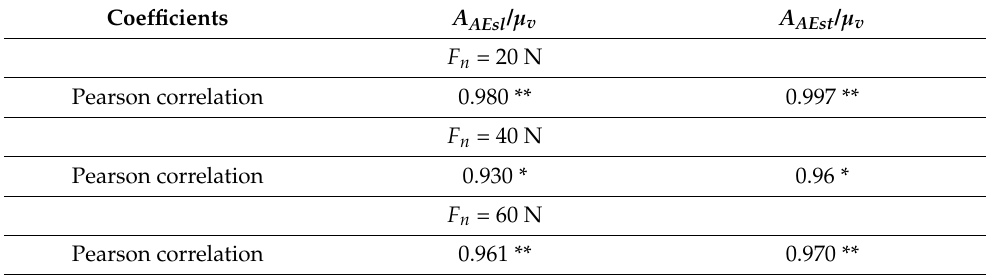
Figure 9. Variation in AE amplitude with driving speed in slip phase ( a ) and stick phase ( b ). The Pearson correlation coefficients were calculated between the amplitude of the acoustic emission, A AEsl and A AEst from the slip and stick phases, respectively, as an independent variable and the amplitude of the stick–slip phenomenon( µ v ) as a dependent variable. The obtained results can be found in Table 3. Table 3. Correlations between the AE and stick–slip amplitudes.